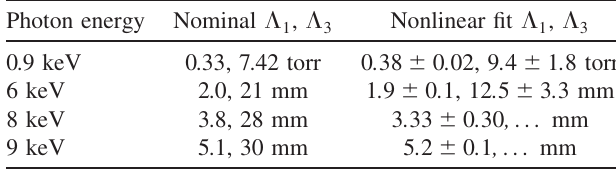
effective due to the low absorption of the third